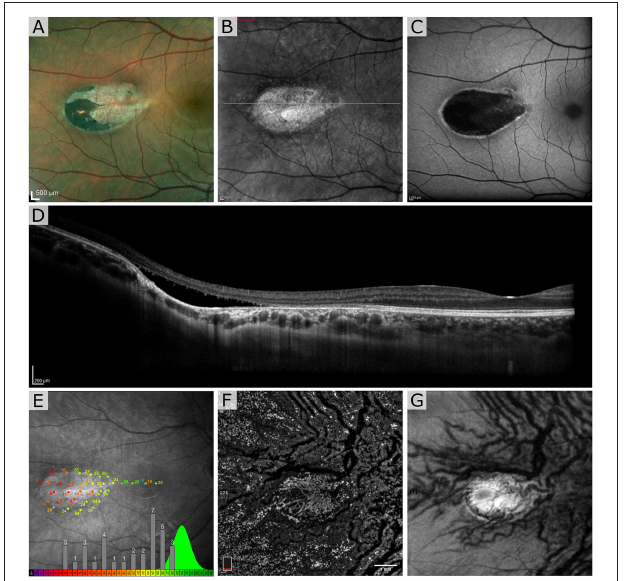
FIGURE 1 | Patient 1 imaged with multimodal clinical imaging. (A) Fundus images show a distinct torpedo-shaped lesion at the temporal macular region with the red box indicating the areas for the scanning laser ophthalmoscopy (SLO) and blue autofluorescence (BAF) images. (B,C) SLO reflectance and BAF image of the lesion showing the lesion very reflective in the SLO image and exhibiting marked hypo-AF signal at the lesion with a rim of hyper-AF. The green line in (B) indicates the B-scan location. (D) Optical coherence tomography (OCT) B-scan through the lesion. (E) Microperimetry test showing normal sensitivity in the fovea and severely decreased sensitivity at lesion with overall sensitivity well outside the normal distribution. The green distribution represents reference data from normal subjects. OCT en face angiogram (F) projection and corresponding structural image (G) taken with the OptoVue using a slab thickness of 70 µ m about 150 µ m below the retinal pigment epithelium (RPE).